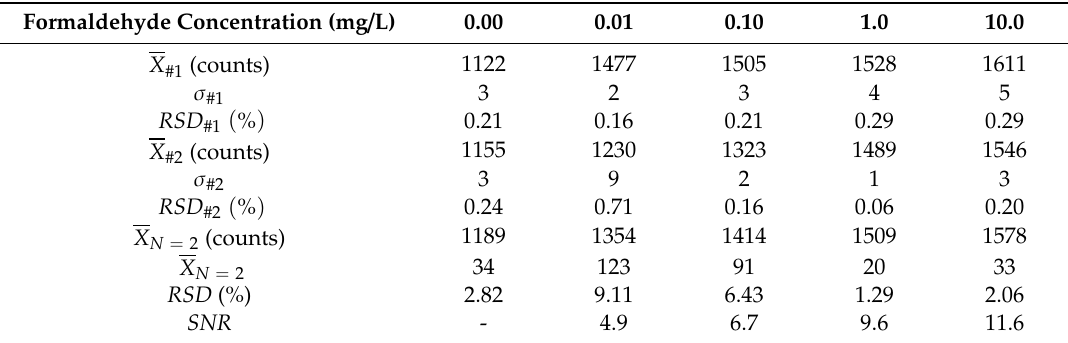
Table 1. Error distribution as the standard deviation ( σ ), relative standard deviation (RSD), and the signal-to-noise ratio (SNR) for the quartz fluidic cell at the excitation optical power, P = 315 mW, where #1 and #2 represented the two independently prepared samples for each of the tested formaldehyde concentrations c i for i = 0, ... , 4. Formaldehyde Concentration (mg / L) 0.00